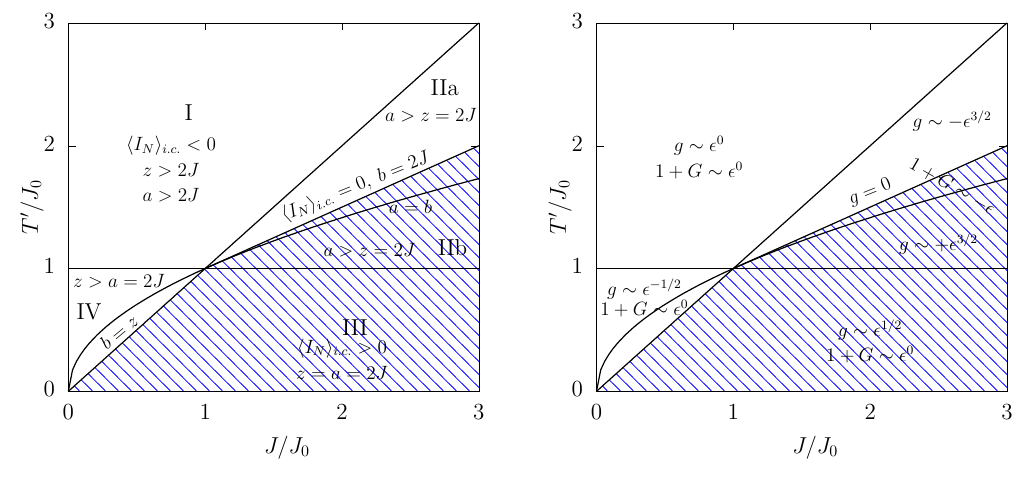
Figure 19: Parameters helping the calculation of the